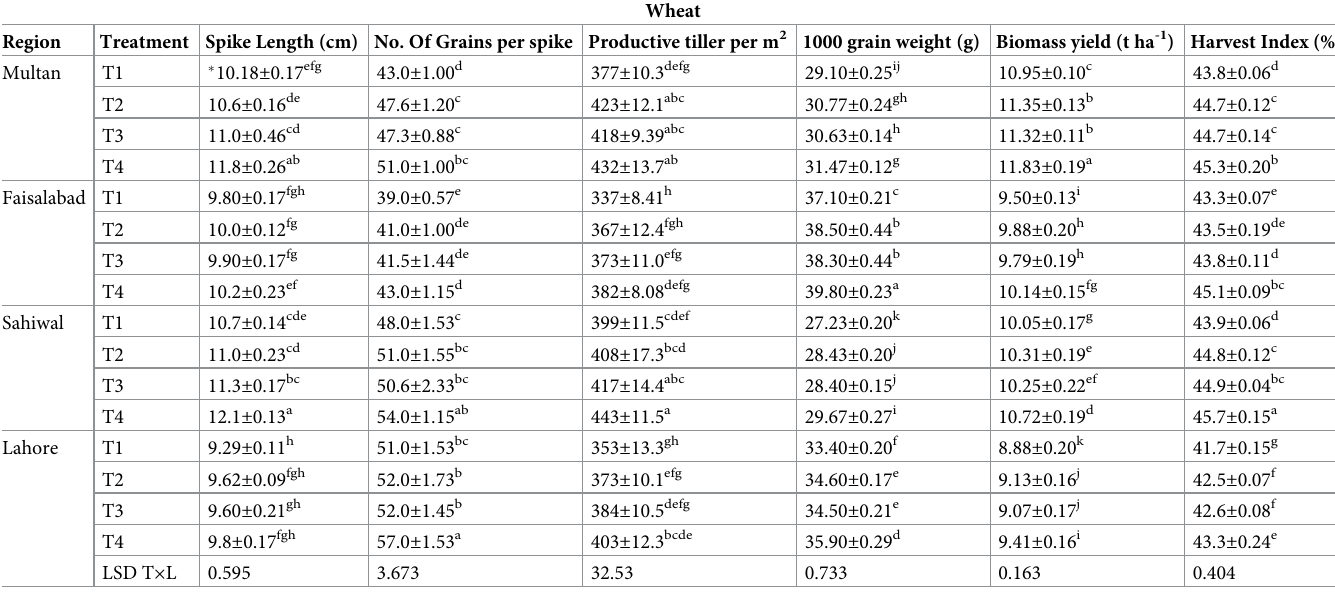
Table 3. Effect of zinc sulfate and bioactive zinc coated urea on growth and yield of